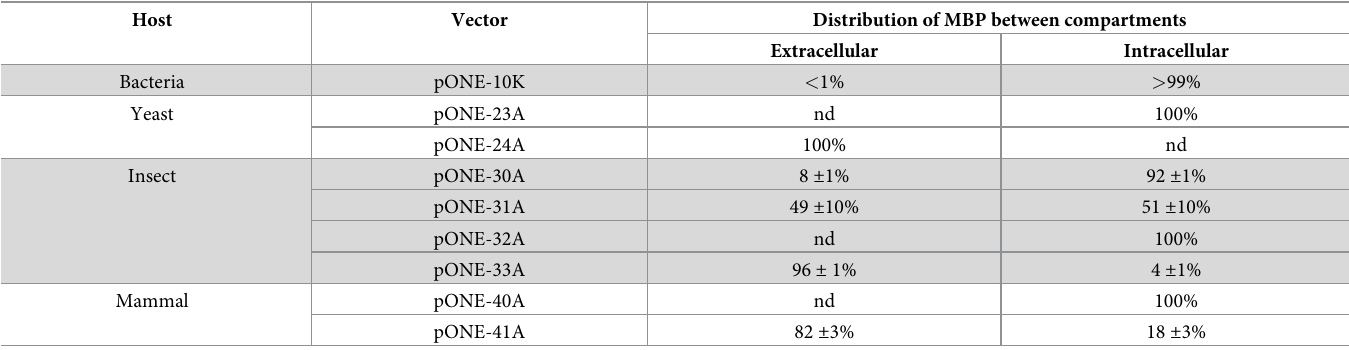
Table 2. Expression yields and localization of recombinant MBP in various hosts. Western blots (Fig 3) were subjected to densitometric analysis using ImageJ software [26]. Results were quantified using calibration standards on each Western blot. From these data relative distributions of MBP between the extracellular and intracellular compartments were calculated. “nd” means “not detected”. Expression patterns of MBP using pONE vectors demonstrate that proteins of interest are expressed and directed to the relevant compartment. Host Vector Distribution of MBP between compartments Extracellular Intracellular